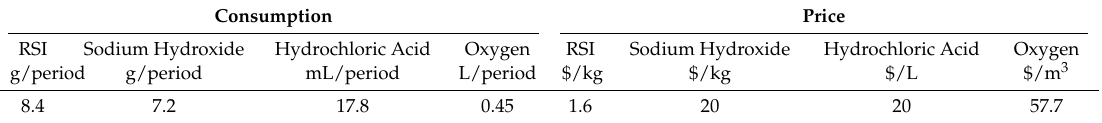
Table 6. The consumption and price of additional materials in the sixth period of sludge